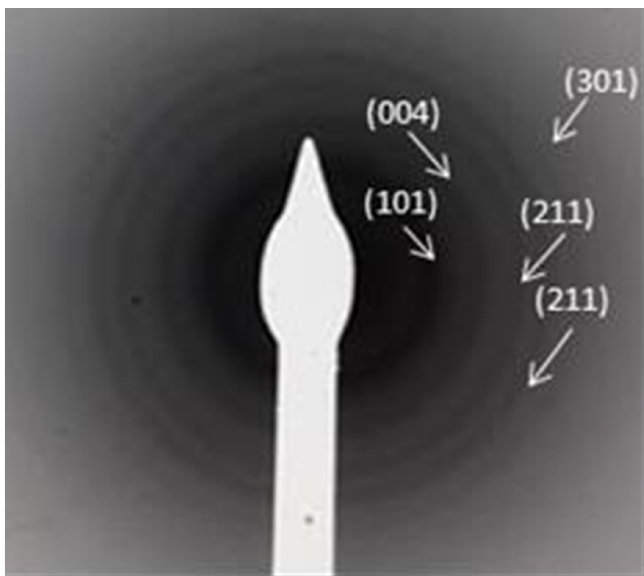
Figure 4. SAED pattern of TiO 2 scaffolds.